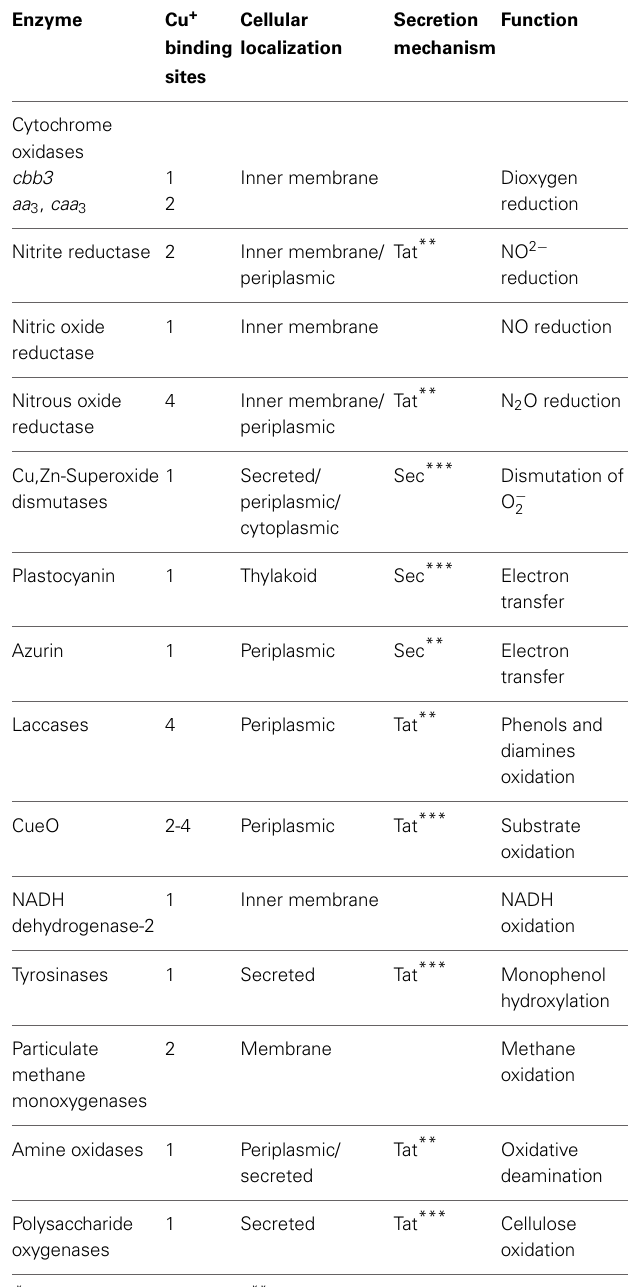
Table 1 | Bacterial Cuproenzymes ∗